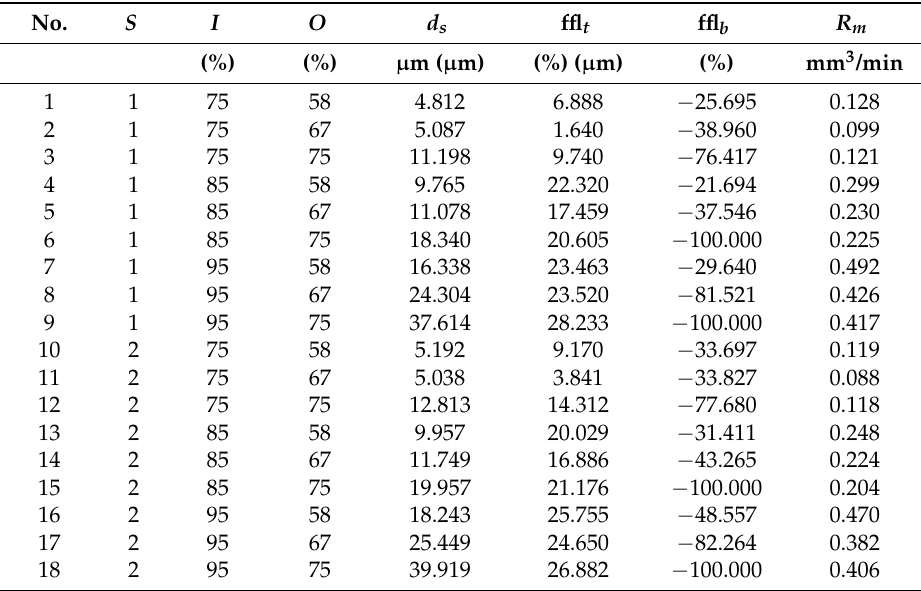
Table 3. Experimental plan using full-factorial approach and performance measures